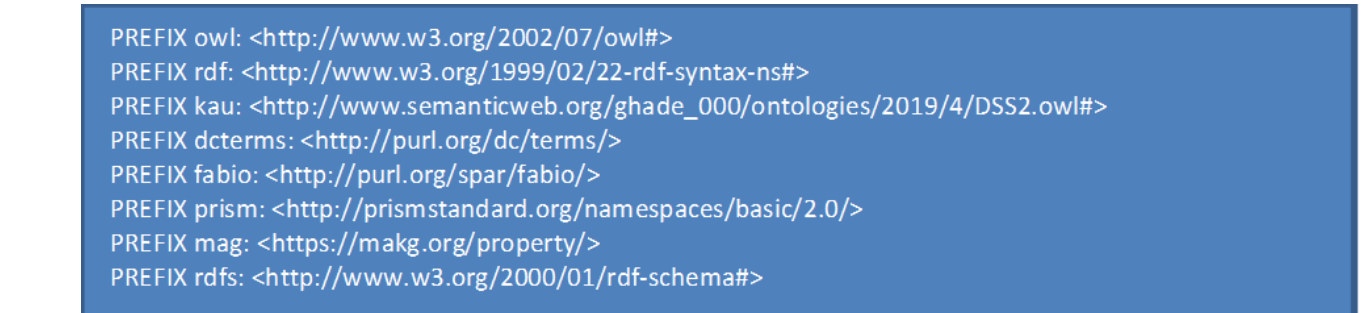
Figure 9. Comparing course elements. According to the testing of the academic profile elements (summarized in Figure 10), the survey depicts the impact of a teacher having taught the course before. The majority of participants believe it is a significant factor in deciding course – teacher distribution. No participant gave a vote against it. In addition, it proves that the research area of the aca- demic teacher is seriously a considerable element that controls the decision, as more than 60% of the votes strongly support it. The academic rank was considered by more than half of the participants. This element can be used to set the teachers ’ priority, when more than one teacher is allocated to teach a specific course. Furthermore, the survey indicated the importance of the certificates the academic teachers have in the course – teacher assign- ment. For a teacher to be the course coordinator, the result shows how essential it is, since 0